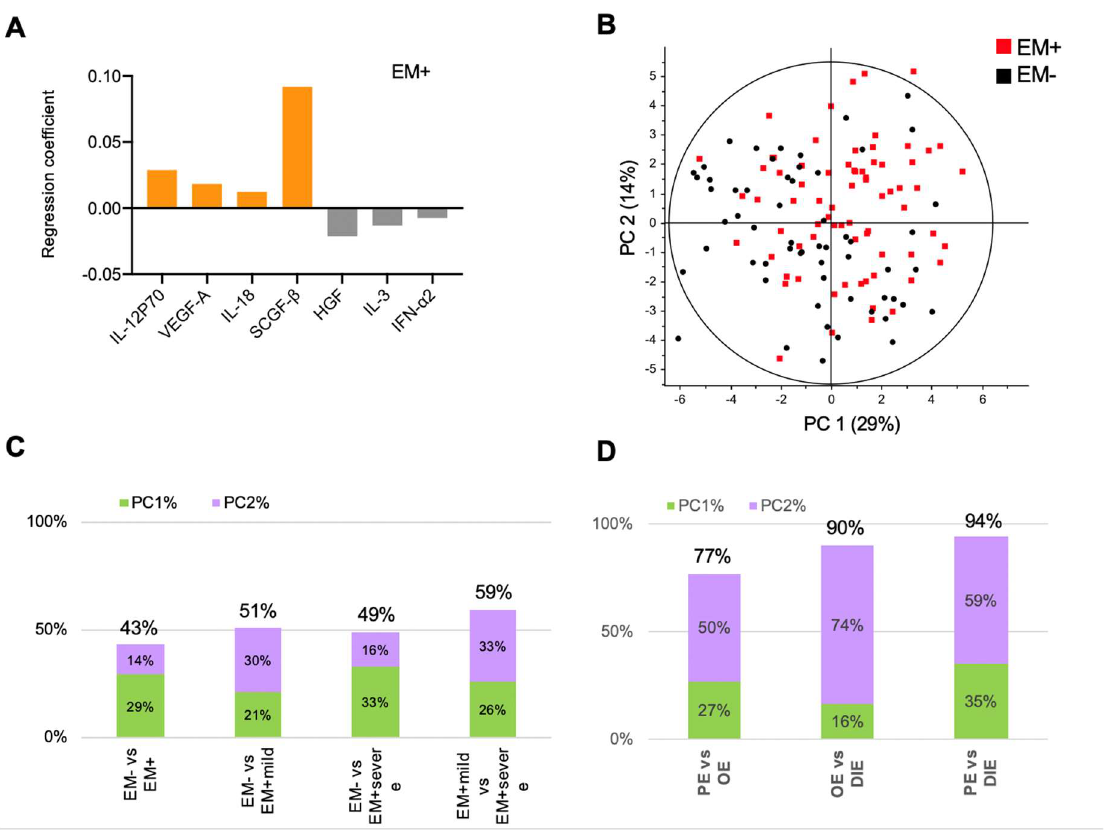
Figure 1. Peritoneal fluid cytokines associate with endometriosis stages. ( A ) Partial least squares regression (PLSR) coefficient analysis revealed a signature comprising elevated IL-12p70, IL-18, VEGF-A, and SCGF-β and decreased IFN-α2, IL-3, and HGF that distinguished women with endometriosis (EM+) from women without (EM-). ( B ) Modeling by PLSR scores plot reveals overlap of EM- and EM+, suggesting heterogeneity in the peritoneal fluid environment. PLSR-derived principal component scores of principal component 1 (PC1) and principal component 2 (PC2) of ( C ) stages and ( D ) subphenotypes. Cumulative principal-component scores are shown at the top of each bar.